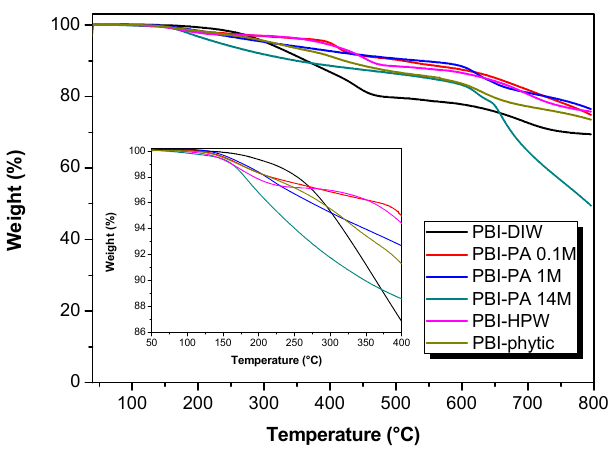
Figure 5. Thermogravimetric analysis of PBI membranes doped with different acids and concentrations. Inset: zoom at the 50–400 ° C region. Table 2. Mechanical properties of the PBI membranes doped under di ff erent